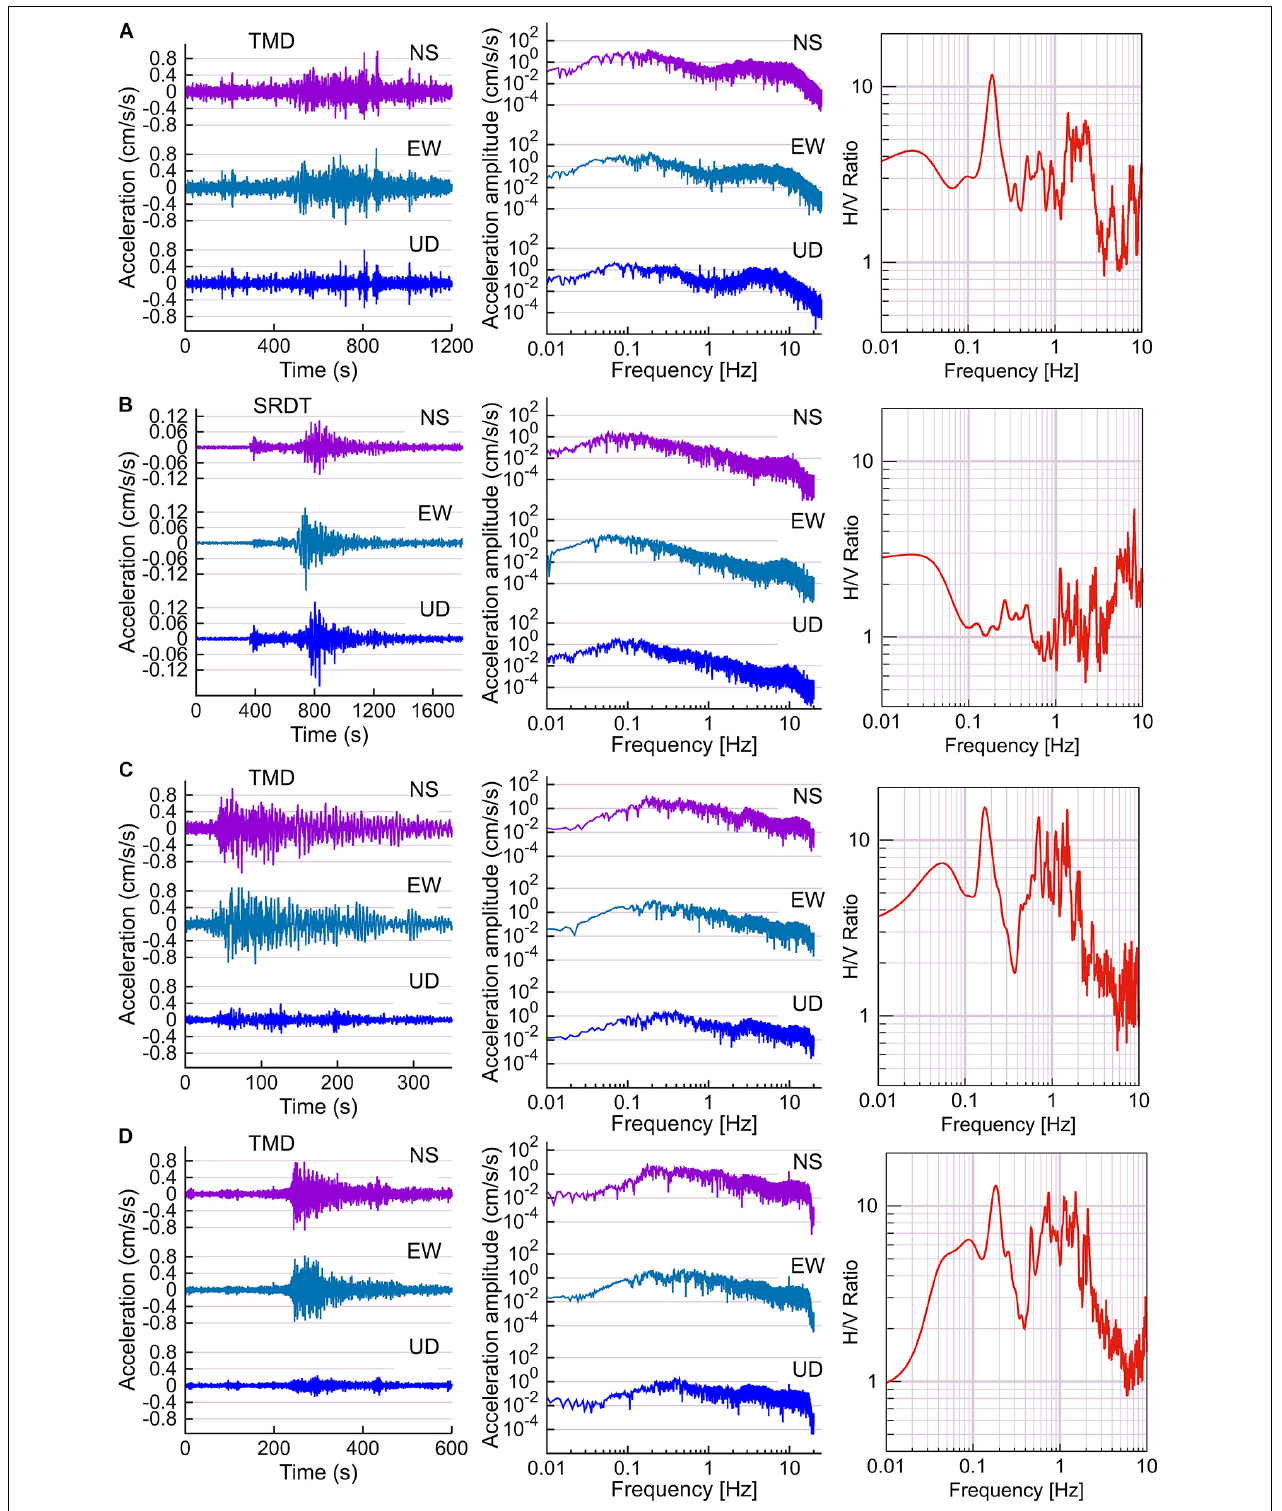
FIGURE 2 | Acceleration time history, Fourier spectra, and horizontal to vertical spectral ratio at (A) TMD station from the 2008 Sichuan Earthquake with sensor located 40 m below the ground surface, (B) SRDT station from the 2008 Sichuan Earthquake. (C) TMD station from the 2011 Tarlay (Myanmar) earthquake and (D) the 2014 Mae Lao (Thailand)